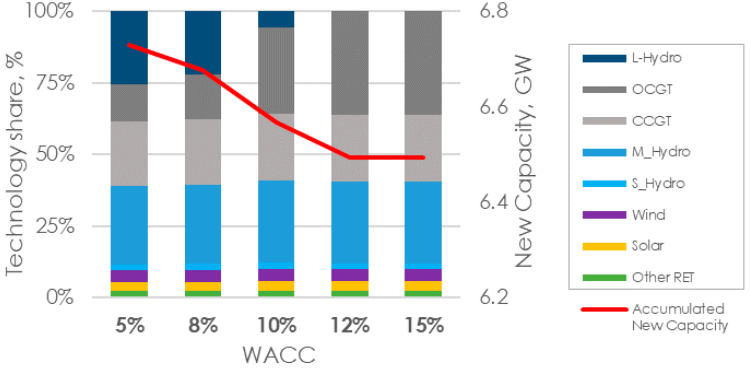
Figure 5. Accumulated new power generation capacity 2013–2040 for all WACC scenarios.